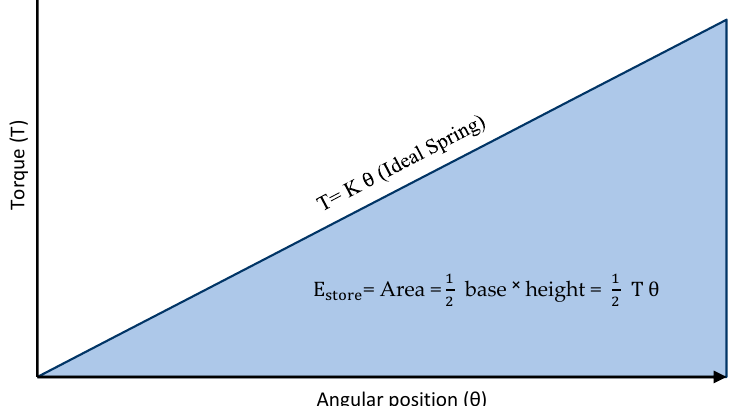
Figure 12. Relationship between the torque and angular position.